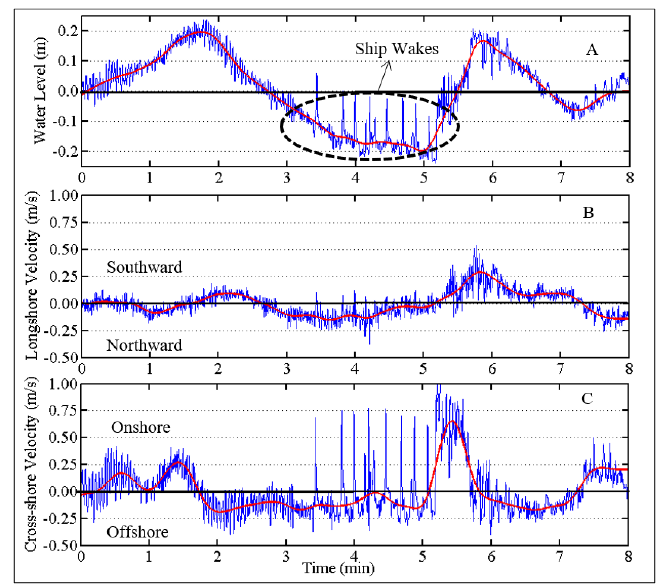
Figure 3. The measured free surface elevation variations and currents at gauge 1 during the passage of two consecutive tsunami waves. Blue lines represent the raw record sampled at 8 Hz. Red lines represent a low-pass filtered record. ( A ) Water-level fluctuation associated with the two tsunami waves. ( B ) Longshore current associated with the tsunami waves. ( C ) Cross-shore current during the two tsunami waves; note the much stronger onshore current during the arrival of the second